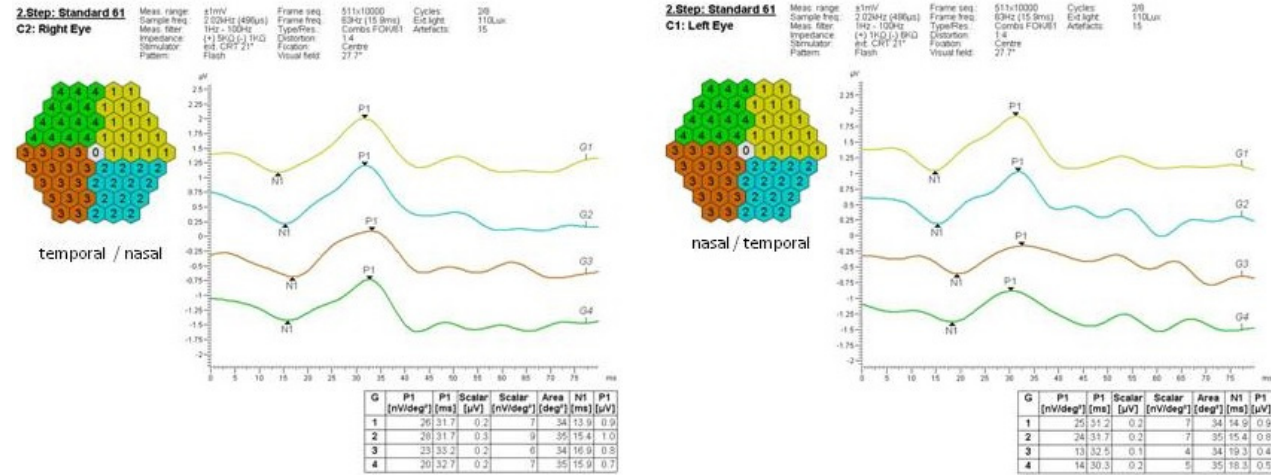
Figure 3. Multifocal electroretinography, amplitude N1P1, quadrant analysis. The deterioration of outer retinal layer function in the left eye is seen as the lower amplitude in the nasal quadrants.